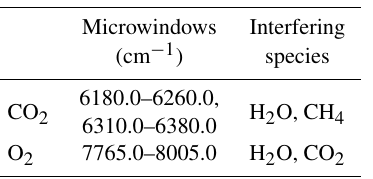
Table 1. Microwindows and interfering species used for CO 2 and O 2